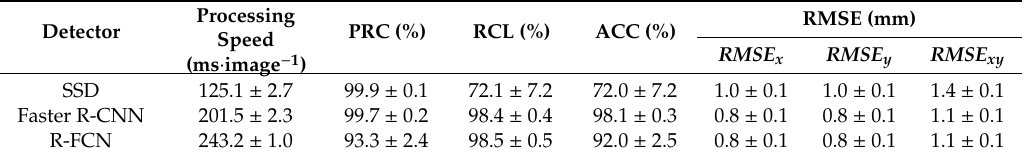
Table 3. Performance (mean ± standard deviation) of three convolutional neural network (CNN) floor-egg detectors on floor egg detection using 1320 images in each of the five